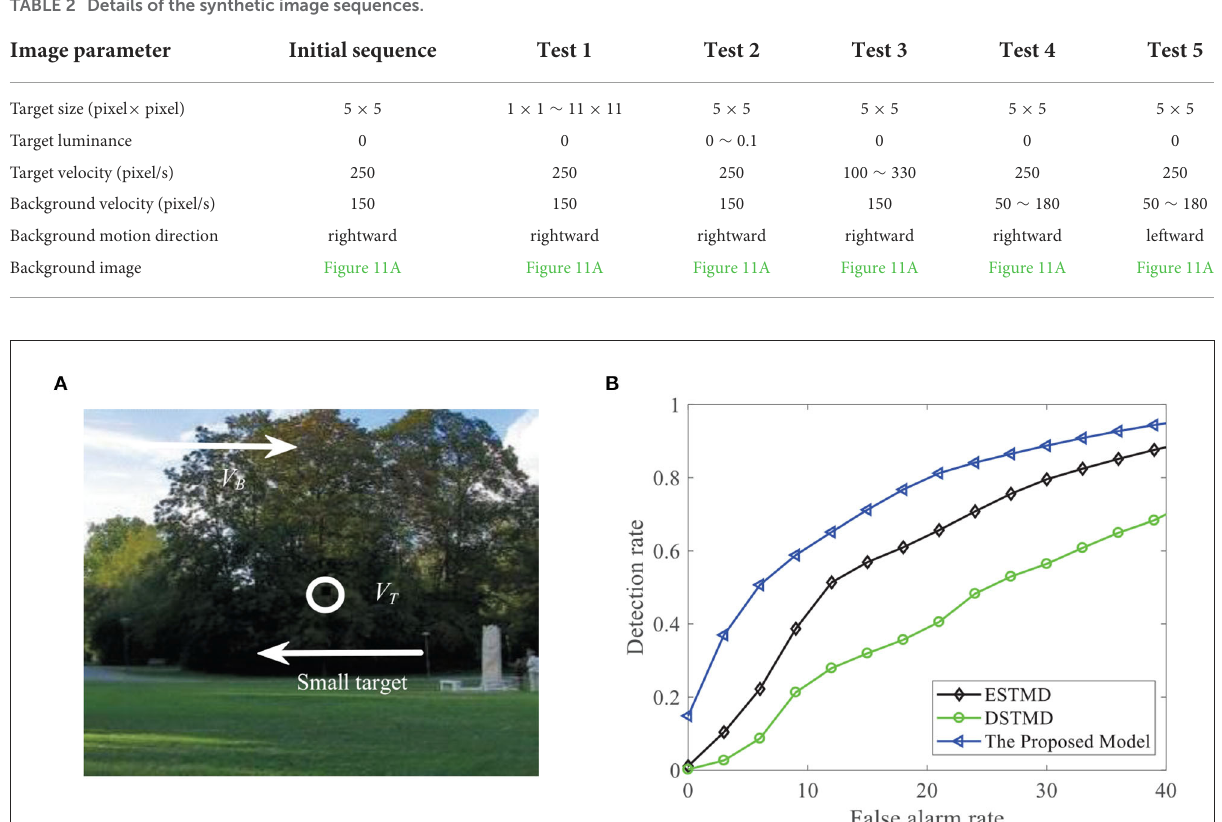
FIGURE11 (A) A frame of the initial sequence. A small target is moving against the cluttered background. Arrow V B denotes motion direction of the background and V T denotes motion direction of the small target. (B) D R